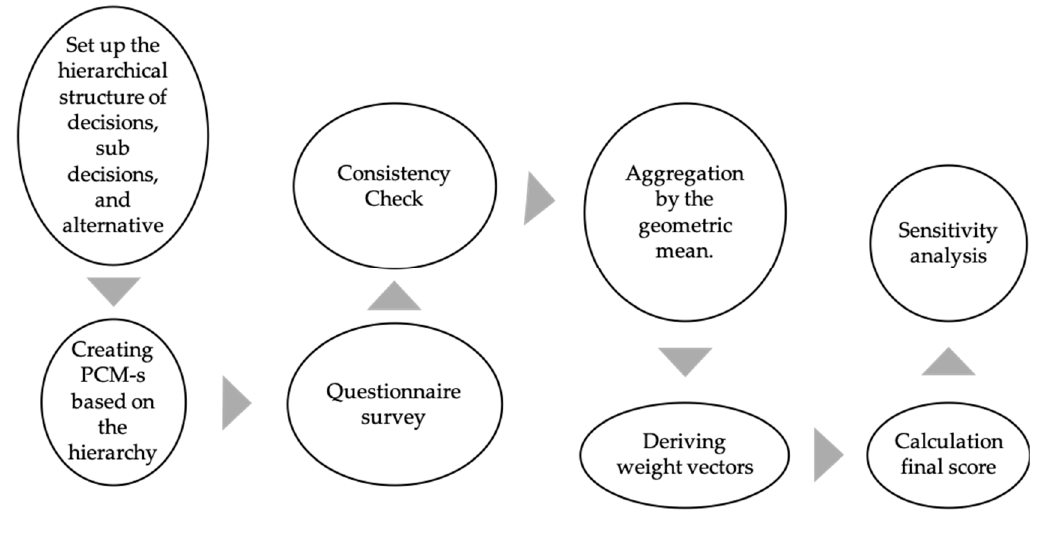
Figure 1. The basic process of the Analytic Hierarchy Process approach (Source: own).